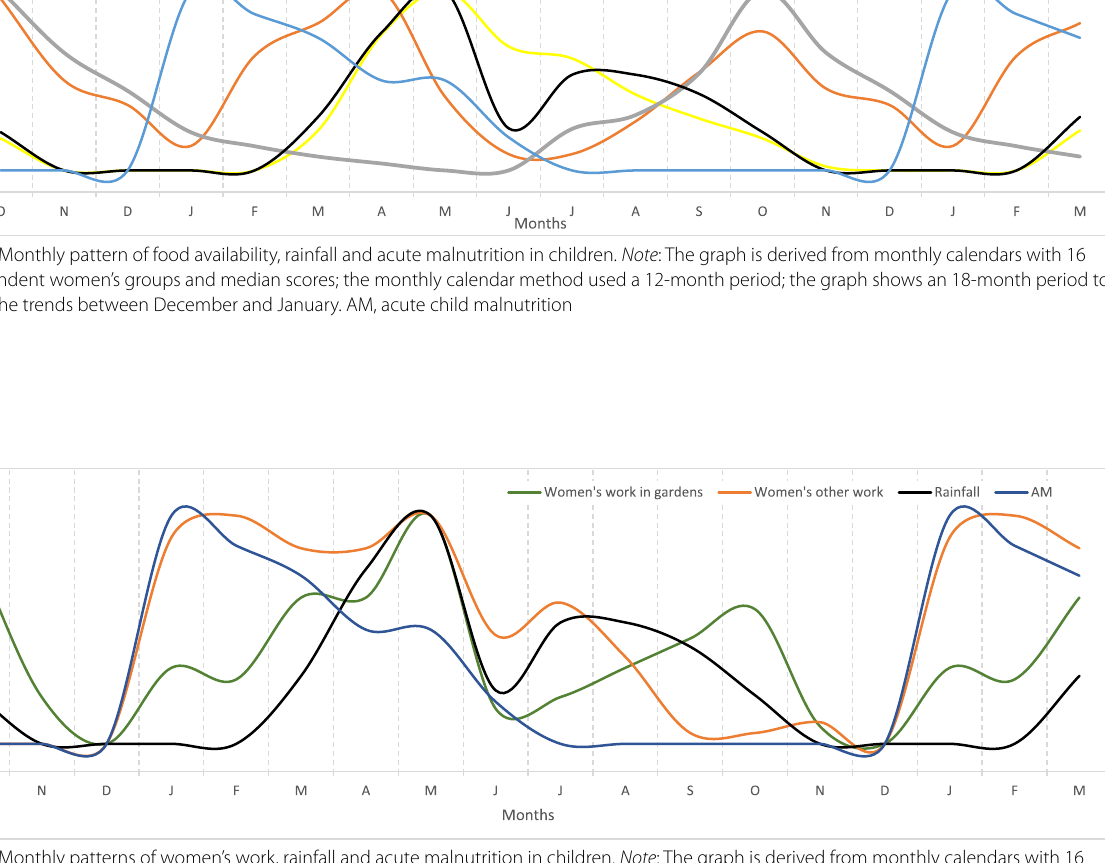
Fig. 2 Monthly patterns of women’s work, rainfall and acute malnutrition in children. Note : The graph is derived from monthly calendars with 16 independent women’s groups and median scores; the monthly calendar method used a 12-month period; the graph shows an 18-month period to clarify trends between December and January. AM, acute child malnutrition